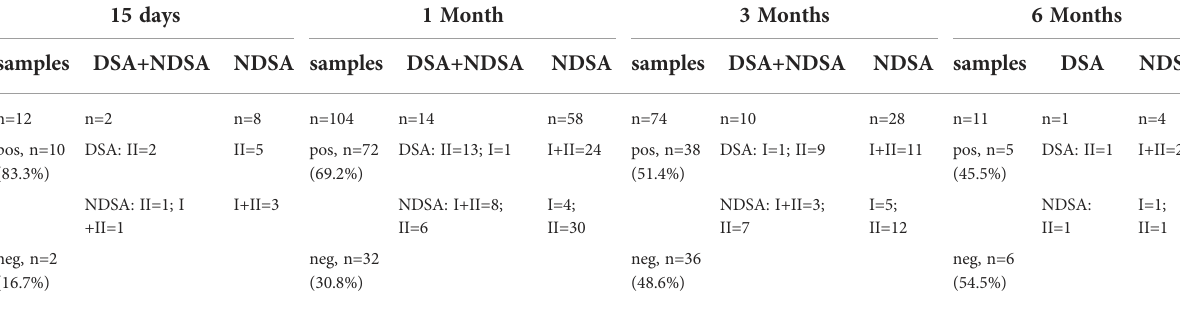
TABLE 2 Number of samples collected at different follow-up times after transplantation and test